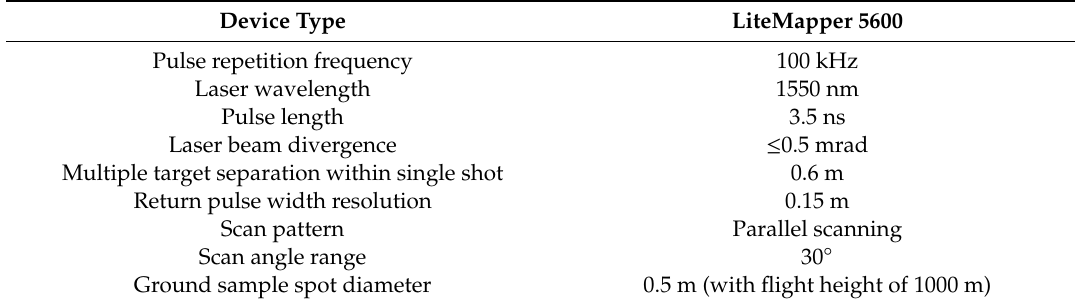
Table 1. Main technical parameters of LiteMapper 5600 system.